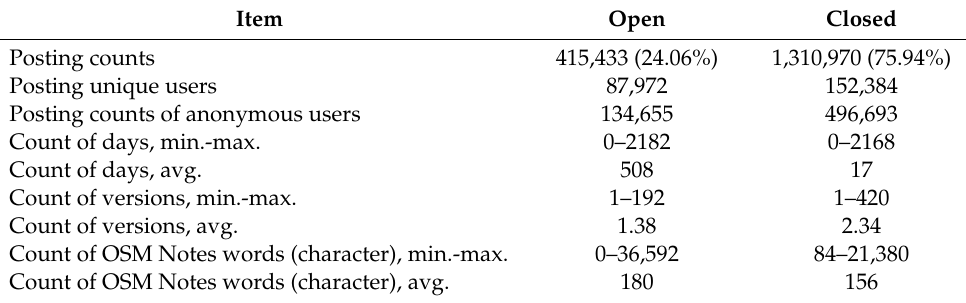
Table 3. Summary of open / closed OSM Notes from April 2013 to April